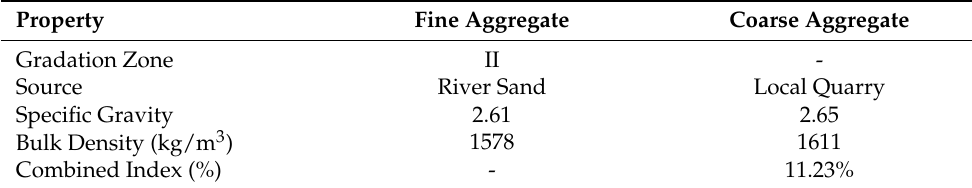
Table 2. Properties of the aggregates.